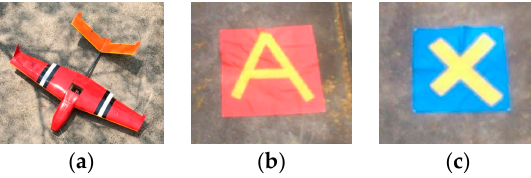
Figure 19. ( a ) The drone simulated a crashed airplane, ( b ) the 2 m × 2 m blue or red target boards represented broken cars and ( c ) the 0.8 m × 0.8 m blue or red targets boards represented injured people to be rescued. Table 1. Basic information for flight tests.